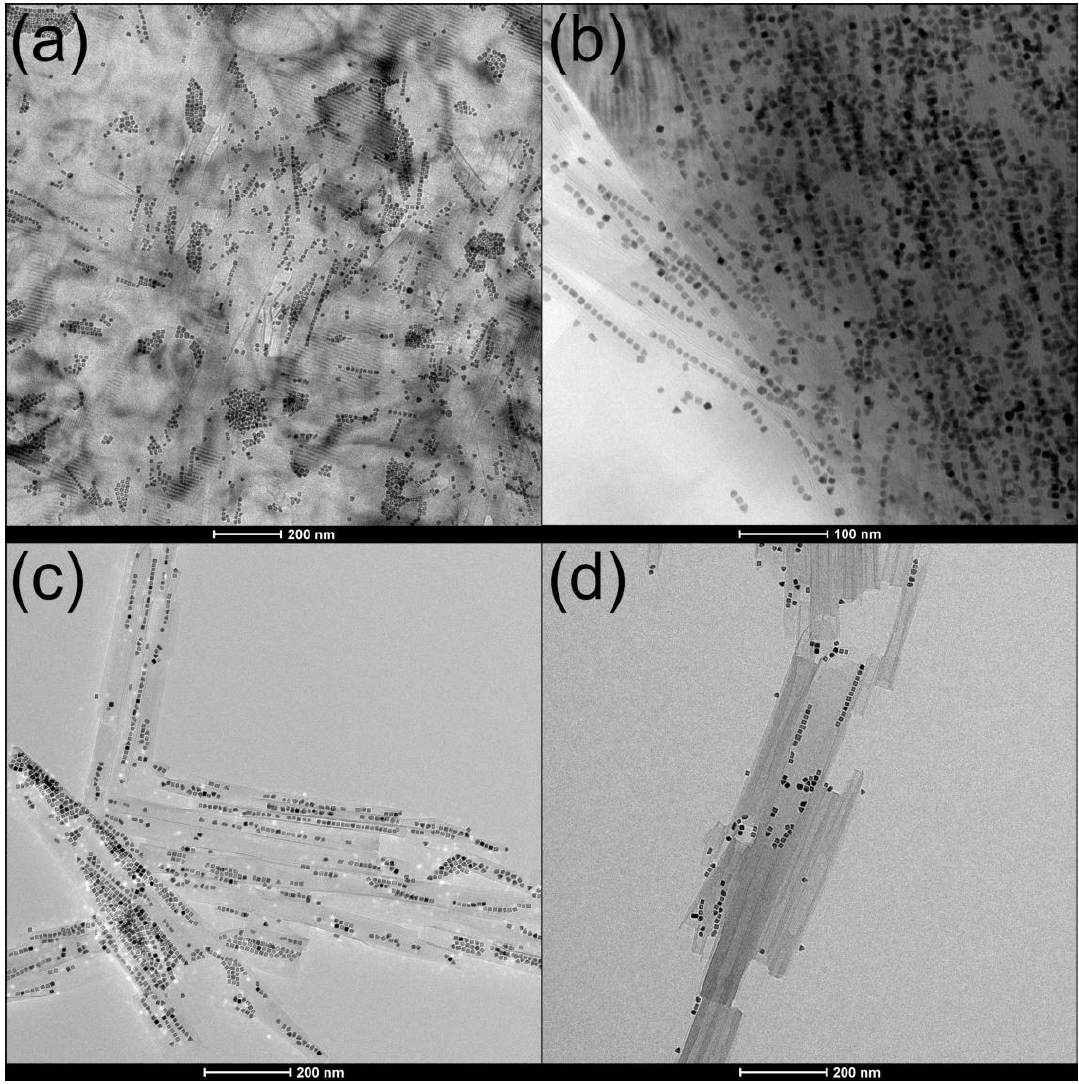
Figure 6. MW-synthesized Pt@HNB NPPs showing deviations from ideal morphology and loading: ( a ) extensive pre- organized NP assemblies on unscrolled hexaniobate surfaces that probably prevented NPP formation; ( b ) failure of NPPs to detach from bulk hexaniobate crystalline; ( c ) one- and two-dimensional NP arrays interfering with complete encapsulation; ( d ) bi-directional scrolling rather than complete NPP formation.